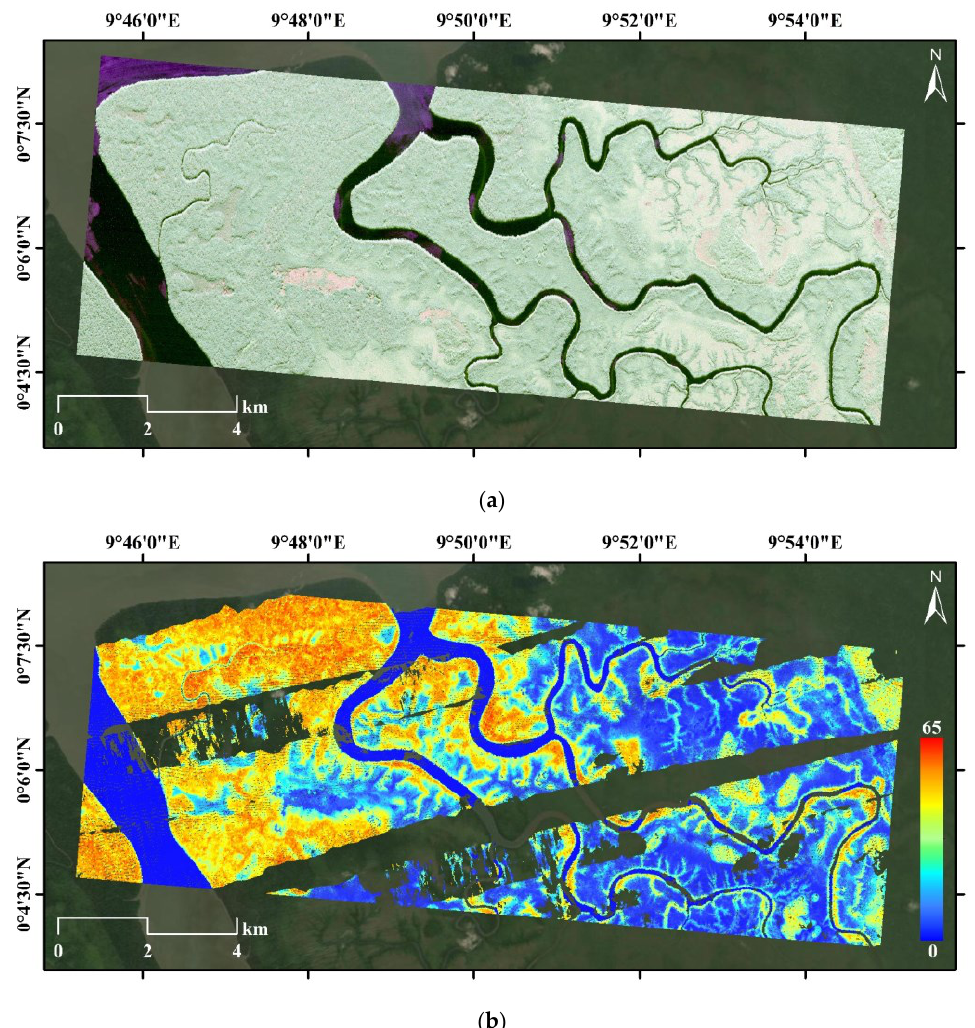
Figure 2. Study area in the Pongara National Park (PNP): ( a ) UAVSAR Pauli color composite image; ( b ) LVIS 2016 RH100 height.